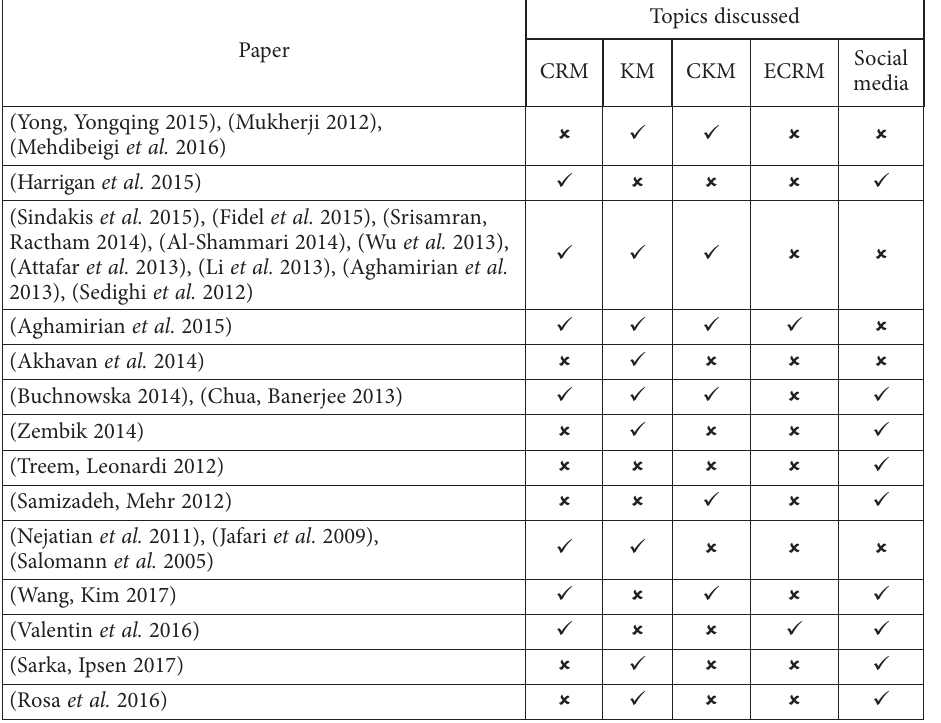
Table 1. Reviewing the literature of CRM, KM, CKM, ECRM and social media